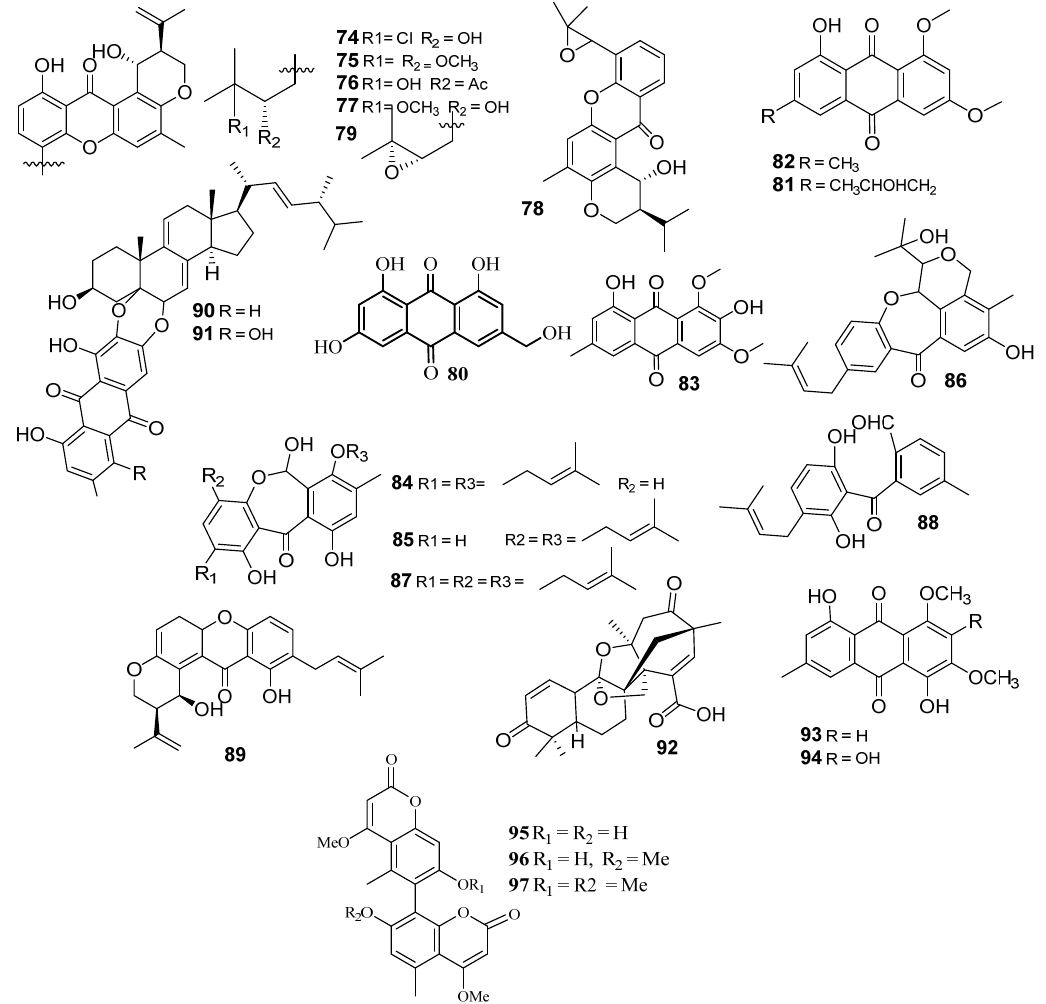
Figure 5. Structures of compounds 74–97.